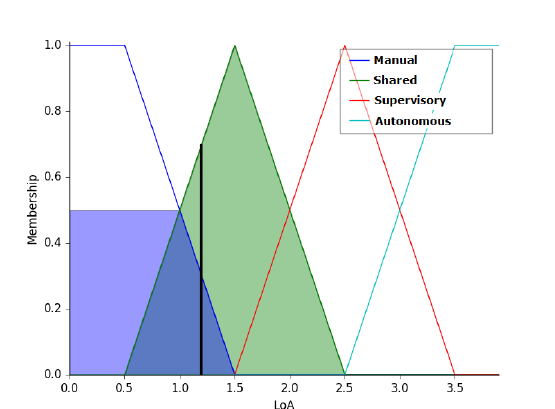
Figure 14. Output of the Fuzzy controller for the input vector (50, − 1.5, − 0.5 − 1). The output is Shared Mode, with 81% of the final speed being controlled by the operator and 19% by the autonomous system.